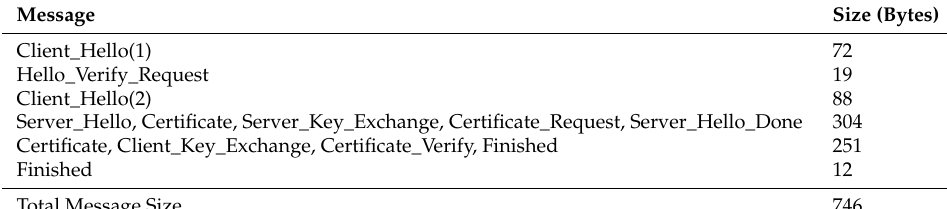
Table 8. DTLS-ECC handshake message